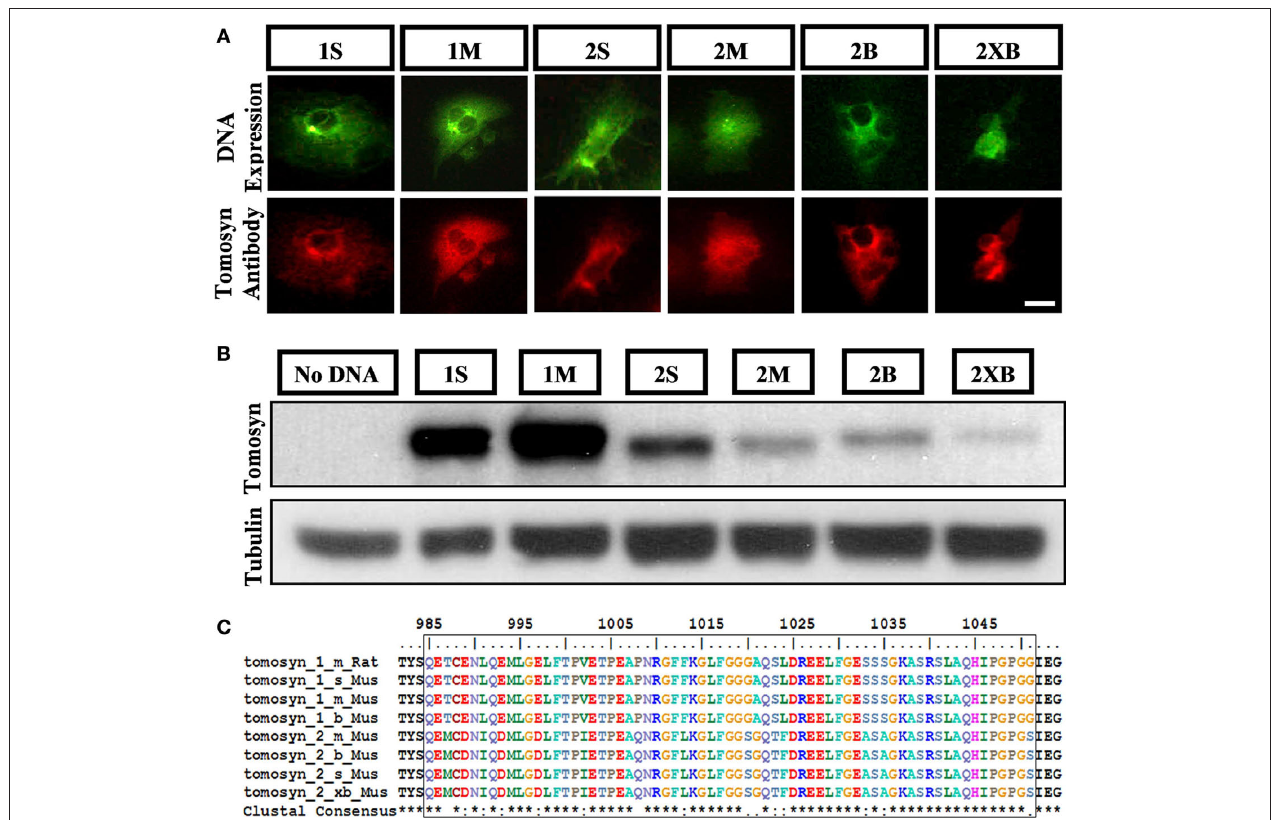
transfected with tomosyn1 and tomosyn2 isoforms, and without DNA as negative control. (C) Multiple sequence alignment of tomosyn1 and tomosyn2 amino acid as aligned to residues 985-1051 of rat tomosyn1-m shows high degree of homology between tomosyn isoforms. The affinity- purified rabbit anti-tomosyn polyclonal antibody was raised against these residues. Scale bar = 5